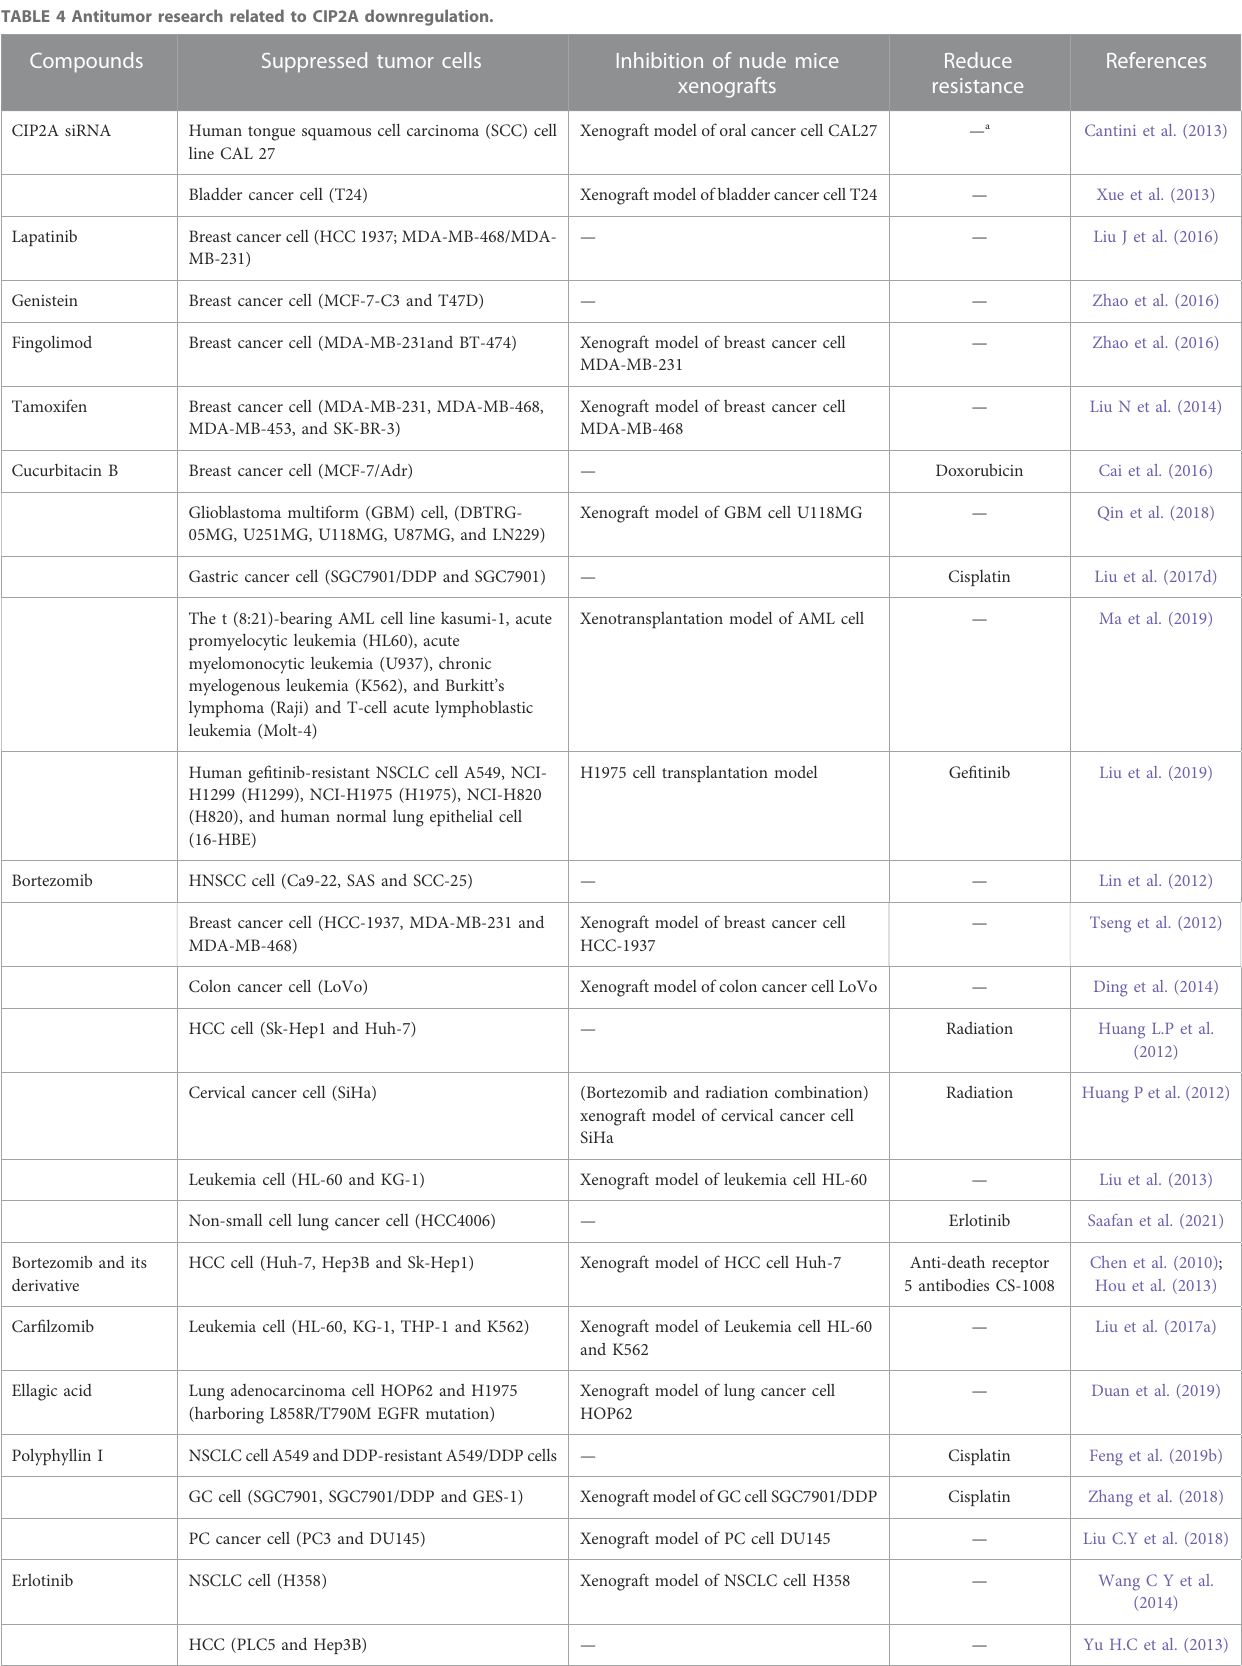
TABLE 4 Antitumor research related to CIP2A downregulation.